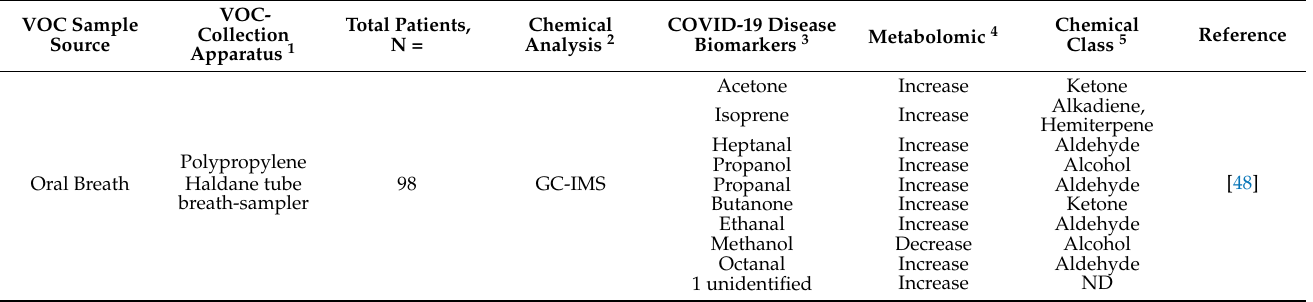
Table 2. Potential disease-specific metabolomic VOC biomarkers identified for possible early detec- tion of COVID-19, caused by SARS-CoV-2